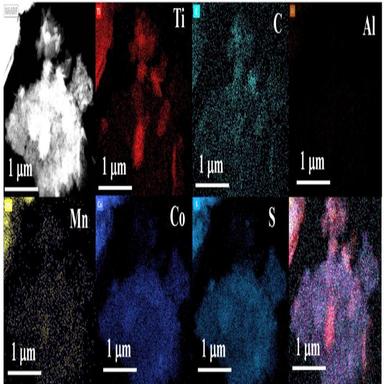
EDS-HAADF imaging of MCS-MXene (1:2).